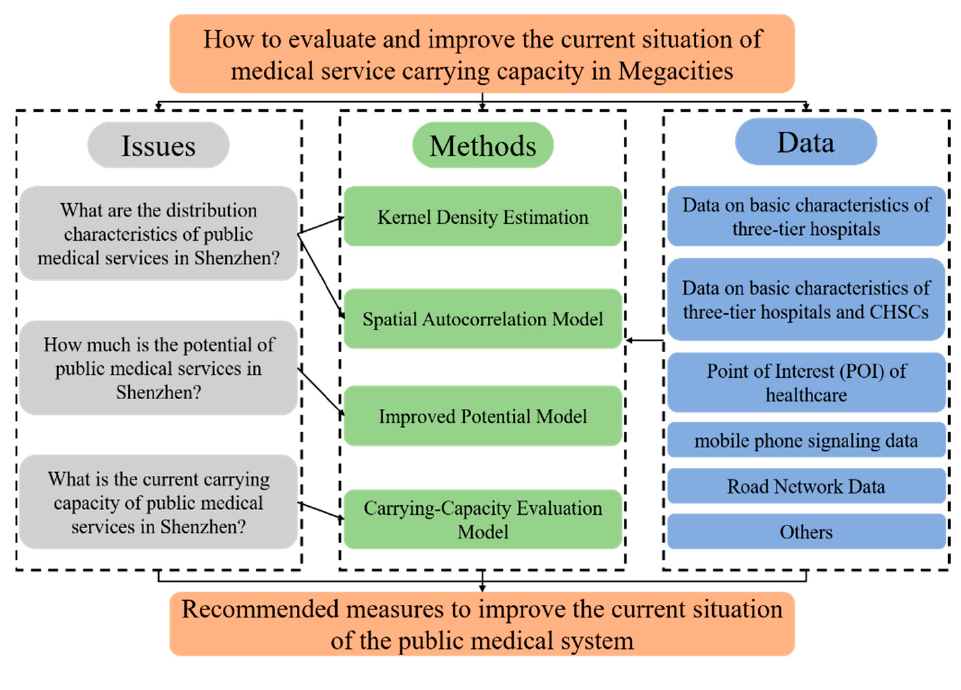
Figure 3. The research framework of the study.